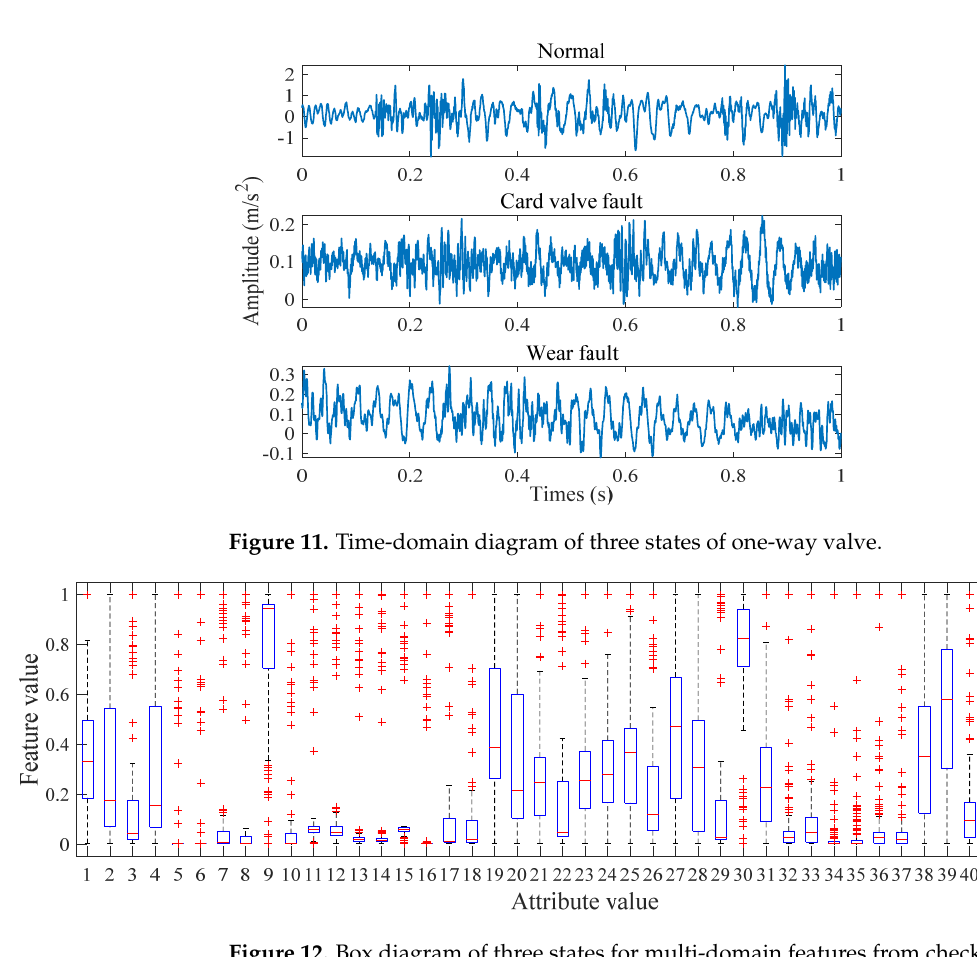
Figure 12. Box diagram of three states for multi-domain features from check valve.